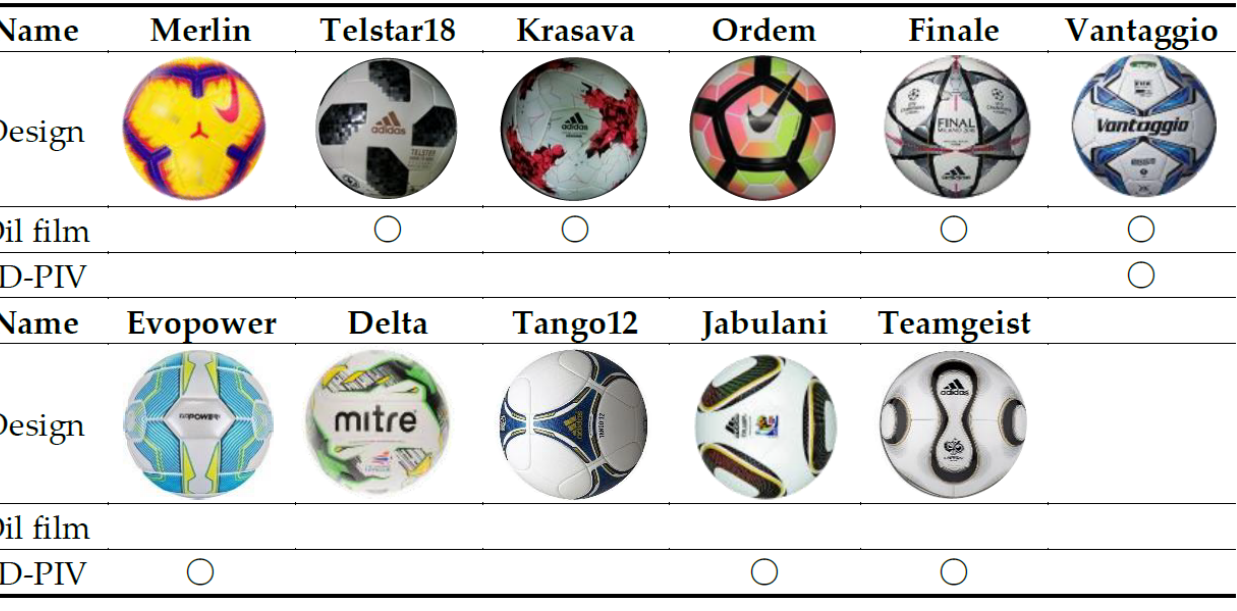
Table 1. A list of the balls measured in this study. Groove and aerodynamic force measurements were performed on all